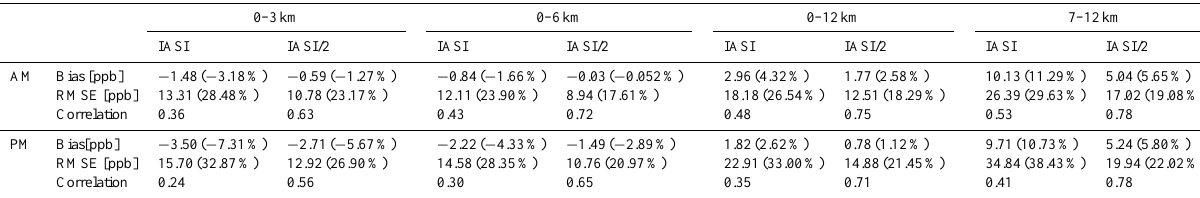
Table 1. Mean biases, RMSEs and Pearson coefficents, with respect to MOCAGE pseudo-reality, averaged over the altitude intervals 0– 3km, 0–6km, 0–12km and 7–12km, for IASI and IASI/2 pseudo-observations for the AM and PM overpasses. Percent values of biases and RMSEs are reported in parentheses.